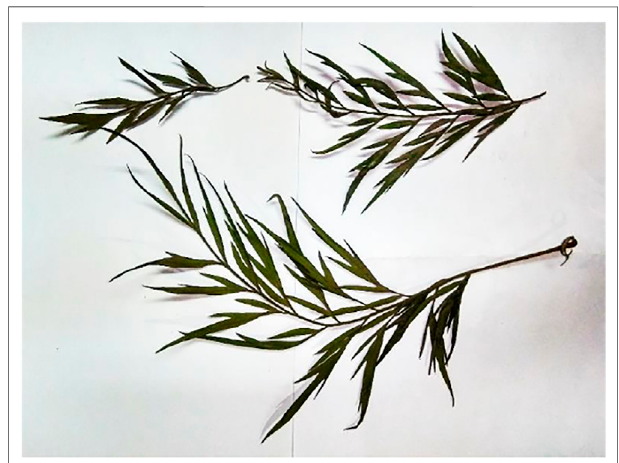
FIGURE 1 | Semi-dried leaves of G. robusta .